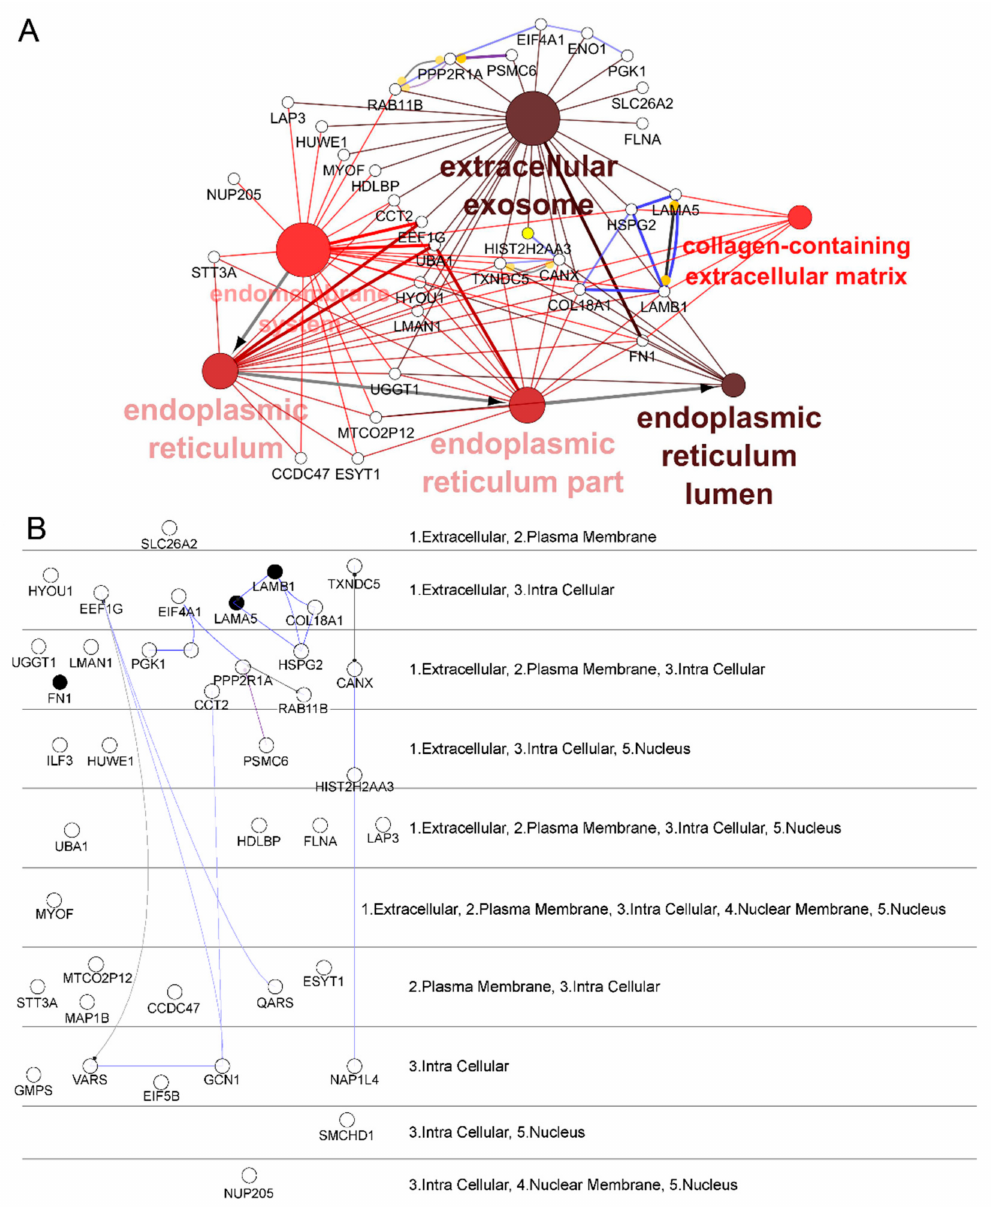
Figure 2. CC-GO functional annotations of candidate proteins identified by nLC-MS analysis. Proteins filtered by a Ph88/WT ratio higher than 1.33 and normalized by the control group were selected. ( A ) The associated CC-GO terms were extracted, enriched and grouped on a functional network, with ClueGO-Cytoscape. The larger the node, the greater the number of mapped genes; the darker the color, the lower the value of p (greater statistical significance). The embedded STRING network, representing the functional association of mapped genes, was created with CluePedia-Cytoscape. Color edge: black represents “reaction”, blue represents “binding”, and purple represents “catalysis”; width edge was scaled according to the confidence score. The mapped protein and its associated terms is shown, highlighting candidate target proteins based on their subcellular location. ( B ) Location of mapped proteins split according to extracellular (1), plasmatic membrane (2), intracellular (3), nuclear membrane (4) or nuclear (5) presence. Cerebral layout of STRING network, showing only interactions between genes, without nodes enrichment. Filled circles represent proteins selected for further